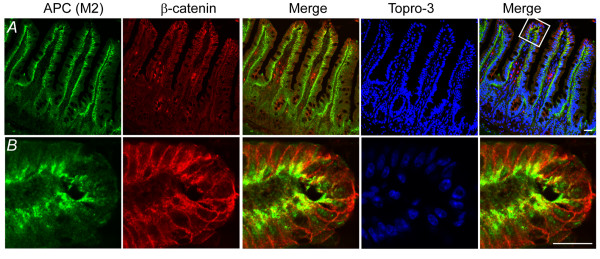
APC-M2 pAb recognizes endogenous APC protein in normal mouse intestinal tissue. Confocal immunofluorescence microscopy of cryosections from wild-type mouse ileum triple-labeled with APC-M2 pAb (green), β-catenin mAb (red) and DNA dye topro-3 (blue). Tissues are oriented so that luminal surfaces are at the top of the images. (A) An increasing gradient of APC staining from crypts to villus tips is apparent at this magnification. (B) Enlarged image of a region at the villus tip shown in (A). APC staining is concentrated in basolateral regions of villus epithelial cells. Scale bars, 20 μm.